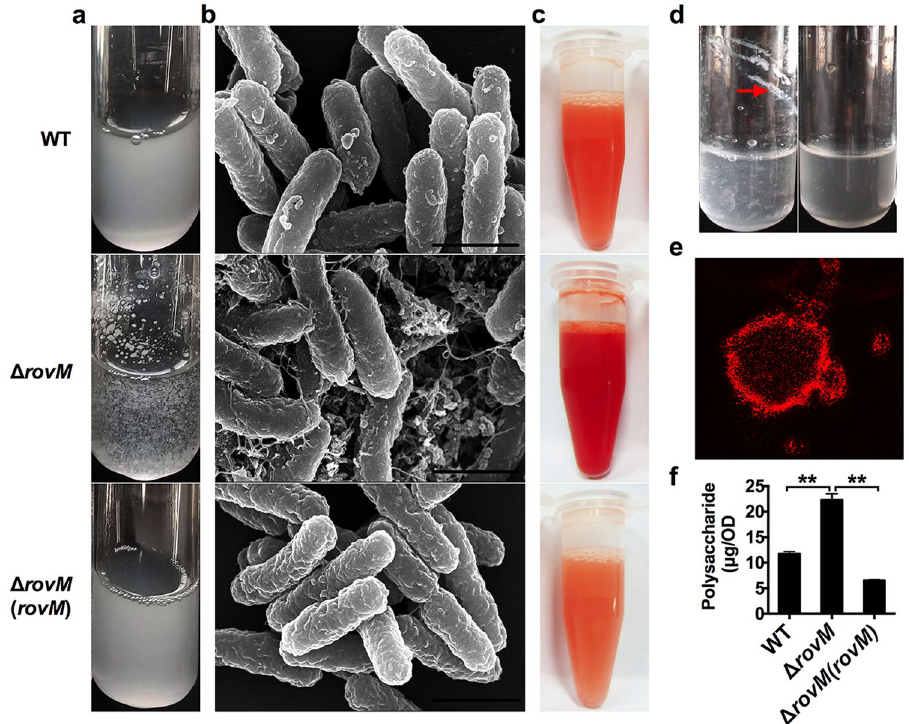
Figure 2. Deletion of rovM causes aggregates. ( a,b ) Observation of cell-cell aggregates formed by wild-type strain, Δ rovM and Δ rovM ( rovM ) grown in M9 medium in tubes ( a ) and under SEM ( b ). Scale bar = 10 μ m. ( c ) WT, Δ rovM and Δ rovM ( rovM ) grown to late exponential phase in M9 medium stained by Congo red. ( d ) Cell aggregates formed in Δ rovM culture were treated with (Right) or without (Left) sodium metaperiodate (1 M) at 4 °C for 24 h. Red arrow indicates aggregate adhered on tube. ( e ) Fluorescence microscopy image of Δ rovM aggregates stained by WGA-R. ( f ) Extracellular polysaccharide content in the Y. pseudotuberculosis WT, Δ rovM and Δ rovM ( rovM ) determined by the MBTH assay. Data shown are the average of three independent experiments; error bars indicate SD from three independent experiments. ** P <